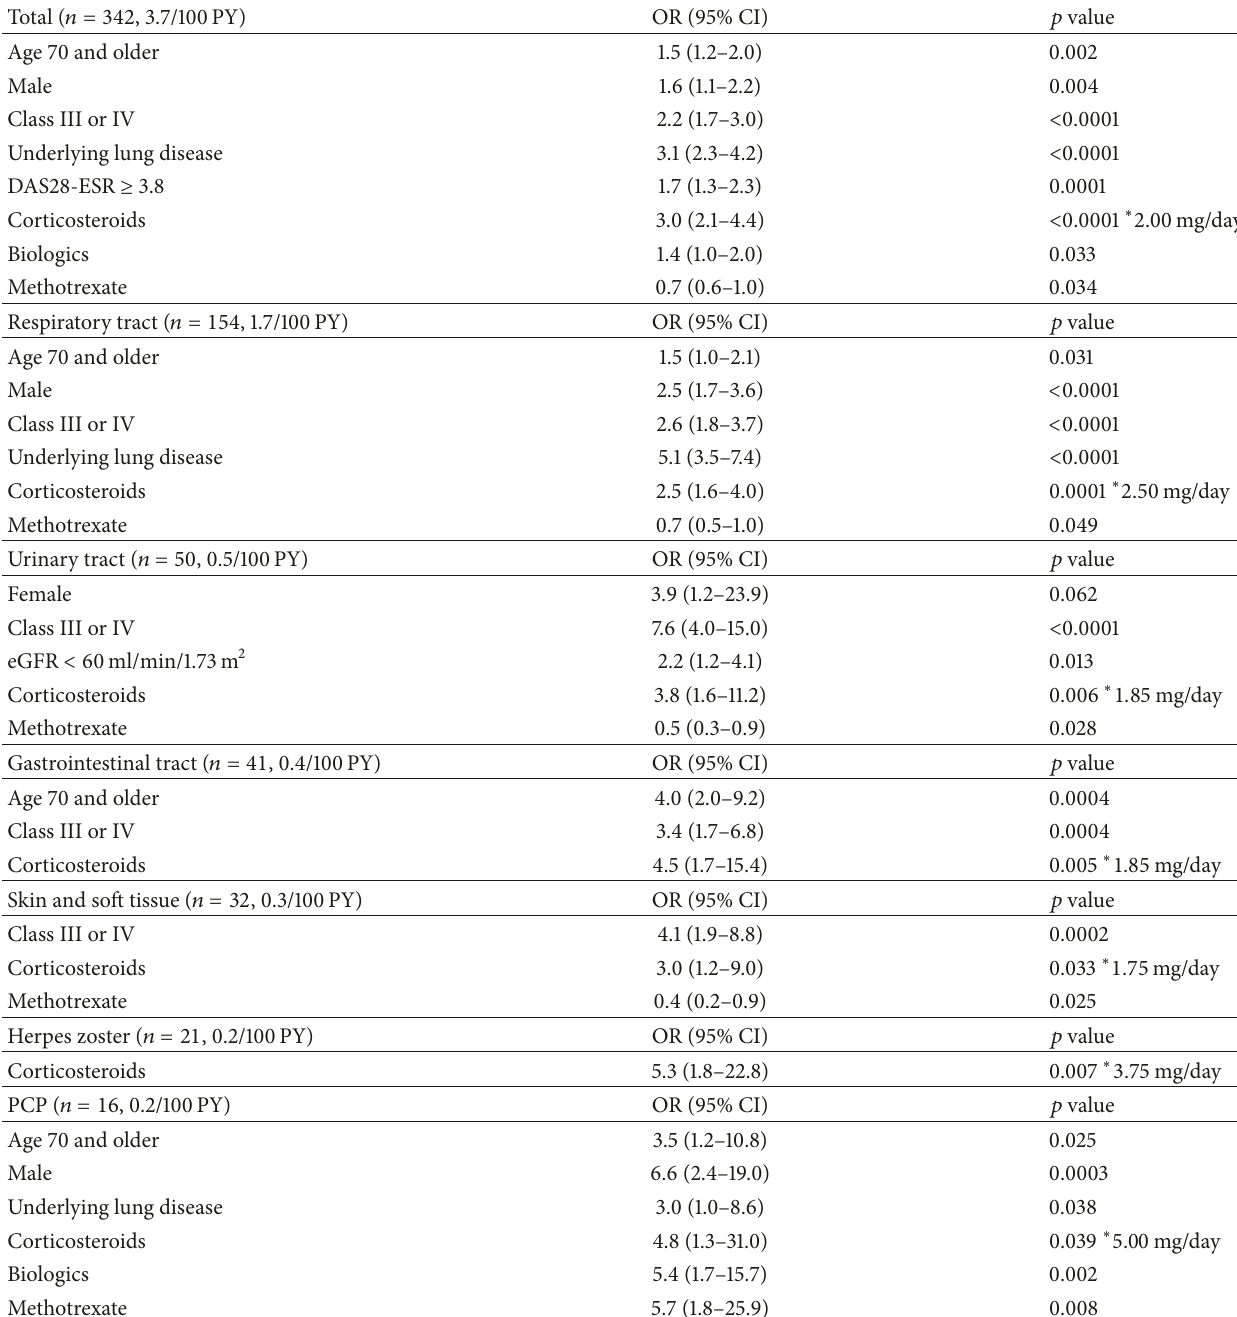
Table 2: Significant risk factors and the odds ratios for each